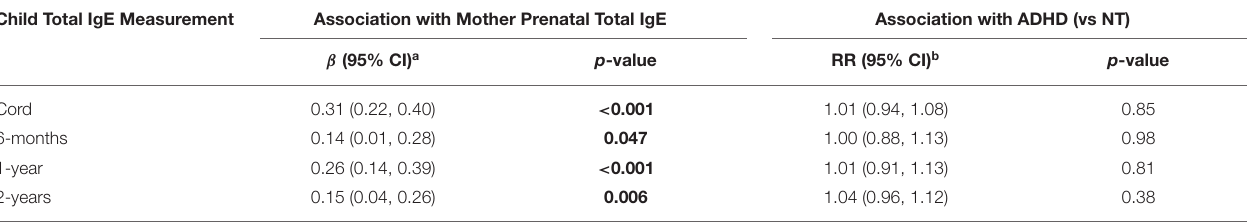
TABLE 4 | Associations between child total IgE and maternal prenatal total IgE and ADHD. Child Total IgE Measurement Association with Mother Prenatal Total